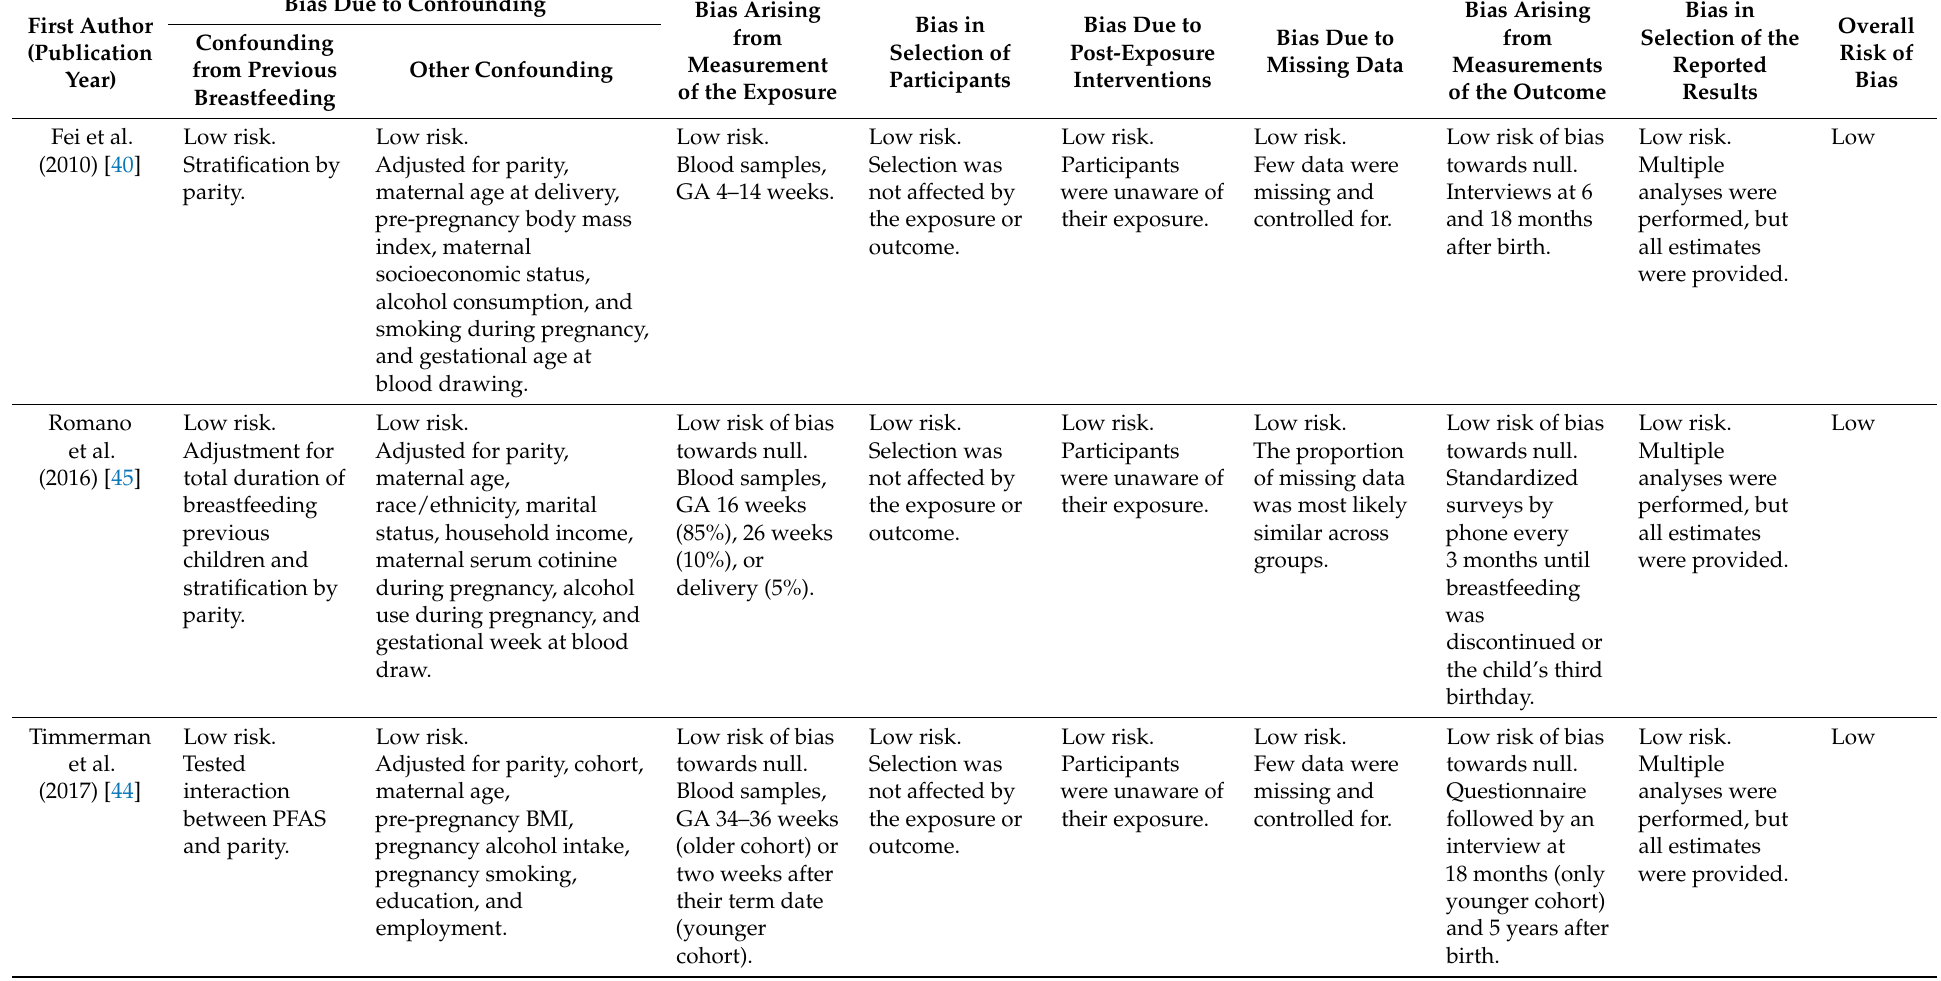
Table 5. Study risk of bias